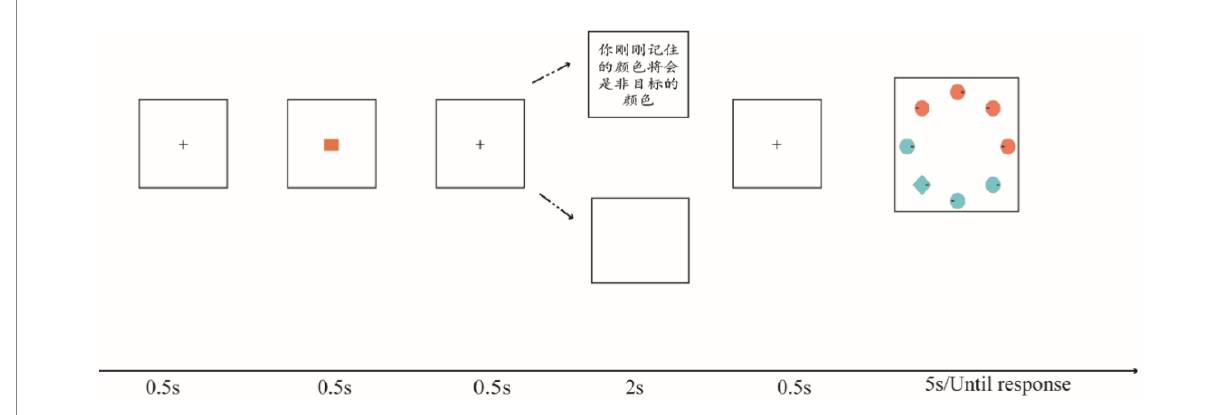
FIGURE 1 Experiment 1 task. The first portions of all trials were identical, beginning with a fixation dot (0.5 s), followed by a memory item (0.5 s), then a predictive cue (2 s) presented to indicate the fate of the remembered item (target or non-target); next, a search test was presented until the response. Participants were required to search for a diamond in a set of circles, then make a judgment about the location of the line. In the no-cue condition, the remembered color was required to be presented in the search display as a target feature or distractor feature. The predictive cues were 100%